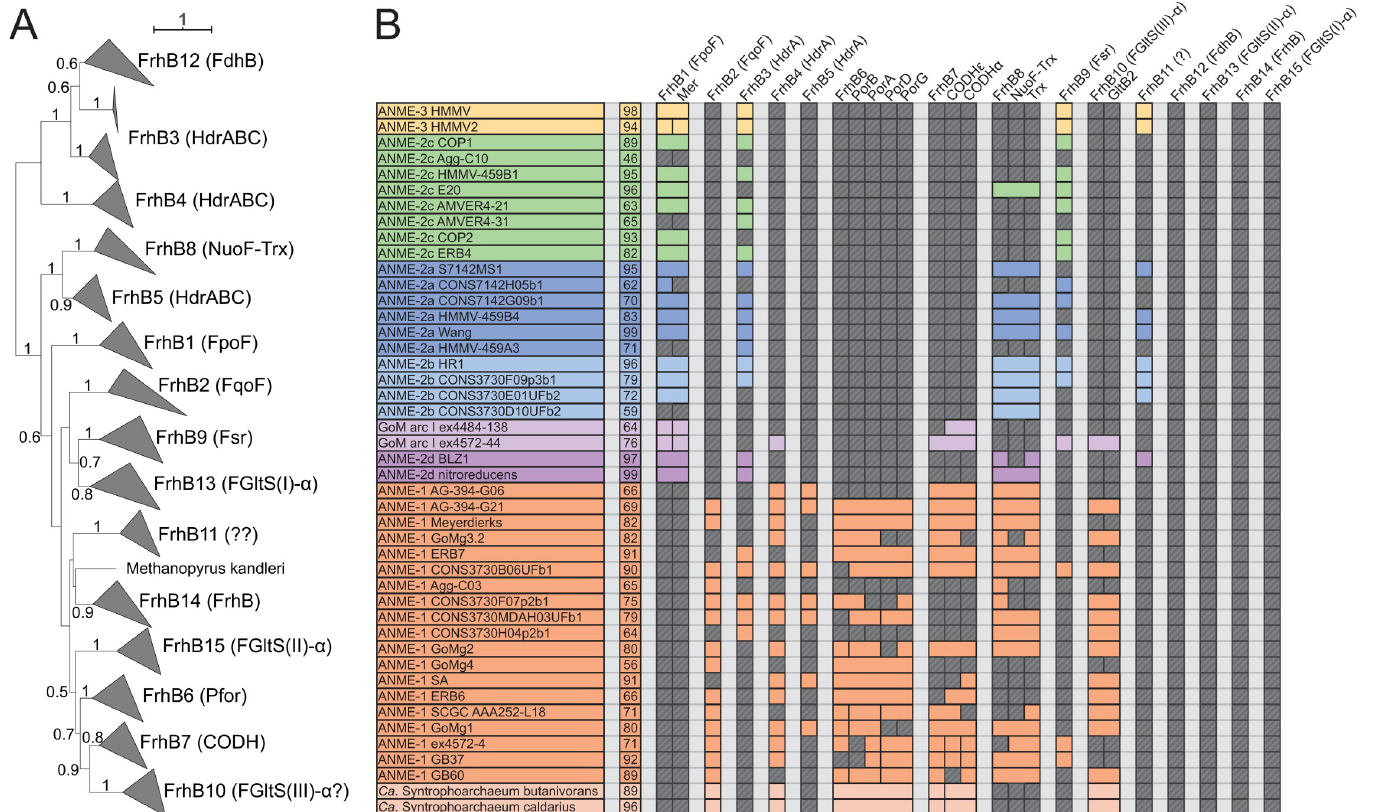
Fig 16. Diversity of FrhB family proteins. Phylogeny and distribution of the FrhB paralogs recovered in our ANME genomes. ( A ) Phylogenetic tree built from all FrhB paralogs in ANME and methanogenic archaea. Major groups have been collapsed (for full tree, see S16 Fig ). Label in parenthesis describe conserved gene cluster; FdhB: F 420 -dependent formate dehydrogenase, FrhB: F 420 -dependent hydrogenase, FqoF: F 420 :quinone oxidoreductase, Fpo: F 420 :phenazine oxidoreductase, HdrA: in cluster with HdrA genes, NuoF-Trx: in cluster with NuoF and thioredoxin genes, Fsr: F 420 -dependent sulfite reductase, FGltS: F 420 -dependent glutamate synthase, Pfor: in cluster with pyruvate ferredoxin oxidoreductase genes, CODH: in cluster with carbon monoxide dehydrogenase alpha and epsilon subunits. Only branch support values > 50% are displayed. Tree scales represent substitutions per site. Tree construction parameters are found in the Materials and methods section. Alignment and tree files can be found in S1 Data . ( B ) Presence of various FrhB paralogs in different ANME genomes. Colored boxes represent presence of various nitrogenase-related genes in ANME genomes. Missing genes are represented by gray boxes with diagonal line fill. Numbers in the second column represent genome completeness. When genes are together in a gene cluster, their boxes are displayed fused together. Gene accession numbers can be found in S2 Data . ANME, anaerobic methanotrophic.